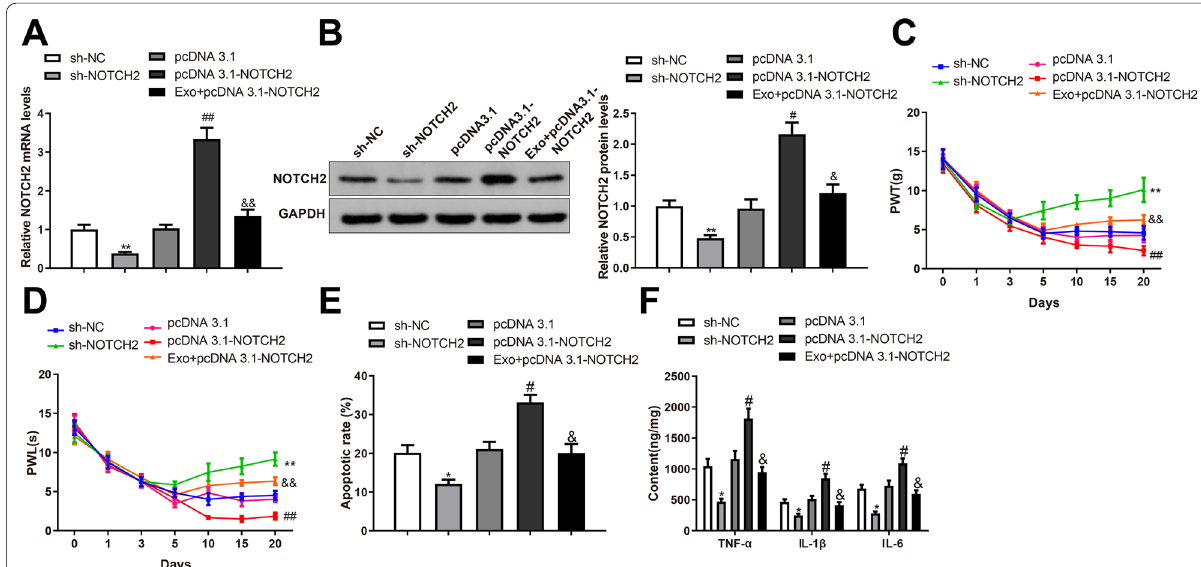
Fig. 5 BMSC-exosomes suppress mechanical allodynia in rats by inhibiting the expression of NOTCH2. RT-qPCR ( A ) and western blotting ( B ) were used to detect the expression of NOTCH2 in rat SDH; Hind paw PWT ( C ) and PWL ( D ) of SNL rats were measured on days 0, 1, 3, 5, 10, 15, and 20 after surgery; ( E ) TUNEL staining revealed the apoptosis in SDH; ( F ) ELISA detected the expression levels of TNF-α, IL-1β, and IL-6 in the SDH. Data were shown as mean standard deviation. N 6. * P < 0.05, vs. the sh-NC group; # P < 0.05, vs. the pcDNA3.1 group; & P < 0.05, vs. the ± = pcDNA3.1-NOTCH2 group. BMSC bone marrow mesenchymal stem cell, SNL spinal nerve ligation, SDH spinal dorsal horn, PWT paw withdrawal threshold, PWL paw withdrawal